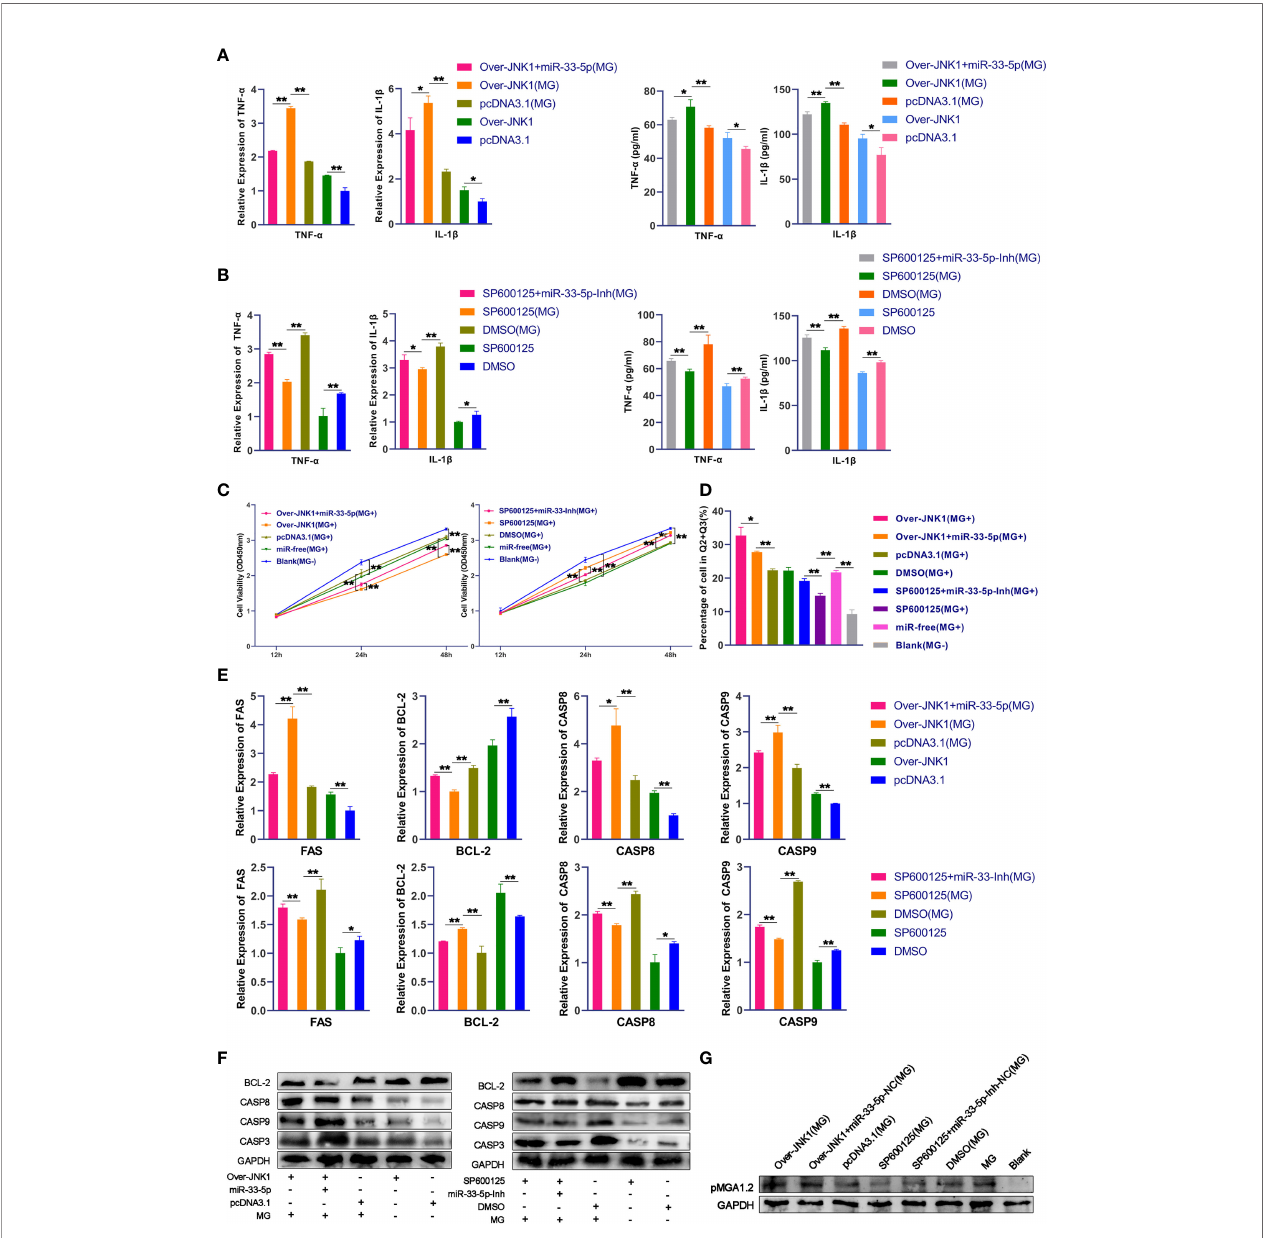
FIGURE 6 | miR-33-5p inhibits MG infection-induced in fl ammation and apoptosis and reduces pMGA1.2 expression through JNK1. DF-1 cells were transfected with the indicated RNA oligonucleotides and infected with MG. (A) The expression levels of pro-in fl ammatory cytokines (TNF- a and IL-1 b ) after treatment with co- transfection of overexpression JNK1 vector and miR-33-5p mimics were detected by qPCR and Elisa; (B) The expression levels of pro-in fl ammatory cytokines (TNF- a and IL-1 b ) after treatment with co-transformation of SP600125 and miR-33-5p inhibitor were detected by qPCR and Elisa; (C) CCK-8 kit was used to detect cell proliferation at 12, 24, 48h post-infection; (D) The cells were stained with Annexin V- PI and analyzed by fl ow cytometer after 24h post-infection; (E) The relative mRNA expression level of apoptosis marker genes after treatment with co-transfection of overexpression JNK1 vector and miR-33-5p mimics or co-transformation of SP600125 and miR-33-5p inhibitor was detected by qPCR; (F) The protein expression of apoptosis marker genes treatment with co-transfection of overexpression JNK1 vector and miR-33-5p mimics or co-transformation of SP600125 and miR-33-5p inhibitor was detected by Western blot; (G) Western blot was used to detect the adhesion protein pMGA1.2 of MG treatment with co-transfection of overexpression JNK1 vector and miR-33-5p mimics or co-transformation of SP600125 and miR-33-5p inhibitor. GAPDH was used as the internal control. Data was expressed as the mean ± SD of three independent experiments, each with three replicates. (* p < 0.05, ** p <